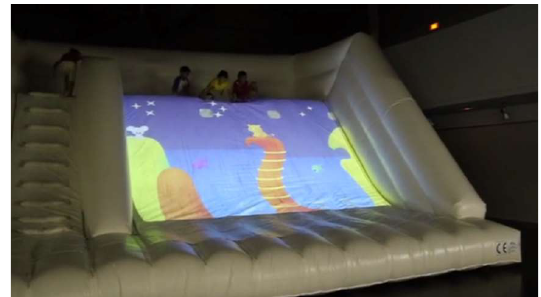
Figure 2. Children playing with the Archimedes game.